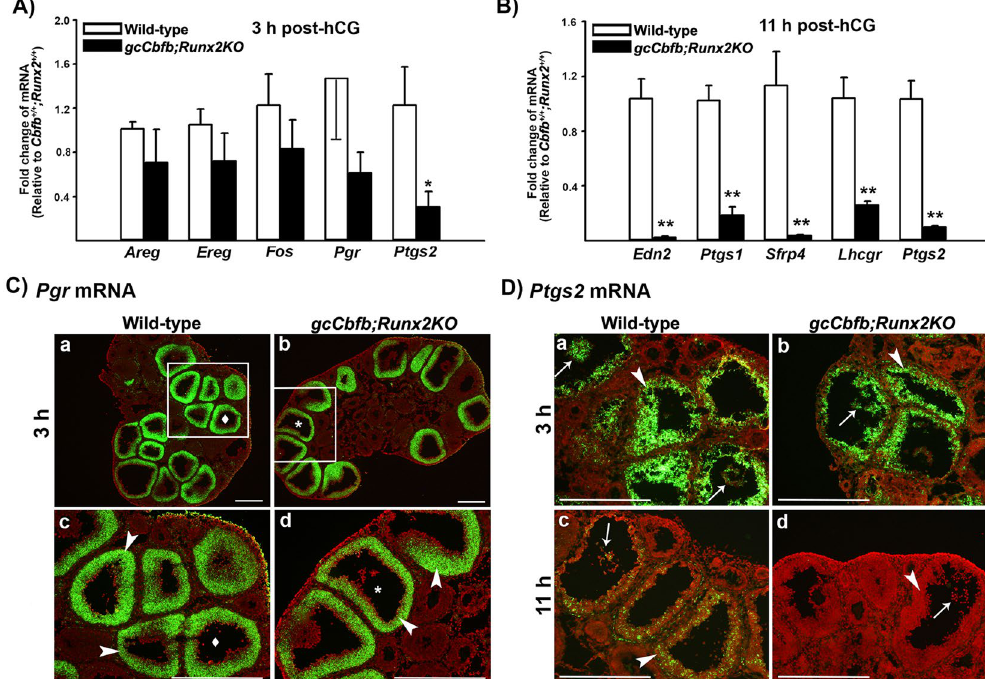
Figure 3. The differential expression of key early and late ovulatory genes in ovaries of gcCbfb;Runx2KO mice. ( A ) Ovaries were collected at 3 h after hCG administration. The levels of mRNA for early ovulatory genes were measured by qPCR, normalizing to the Rpl19 value in each sample (n = 7 and 6 for control and mutant mice, respectively). * p < 0.05. ( B ) Ovaries were collected at 11 h after hCG administration. The levels of mRNA for late ovulatory genes were measured by qPCR, normalizing to the Rpl19 value in each sample (n = 8 and 7 for control and mutant mice, respectively). ** p < 0.01. ( C & D ) The localization of Pgr mRNA and Ptgs2 mRNA was evaluated via in situ hybridization analyses in ovaries collected at 3 and 11 h post-hCG (n = 3/genotype). Green fluorescence staining represents transcripts for these genes. The tissue sections were counterstained with propidium iodide (red). Arrowheads and arrows point to granulosa cells of preovulatory follicles and expanded cumulus cells, respectively. Scale bars, 500 μ m for all the